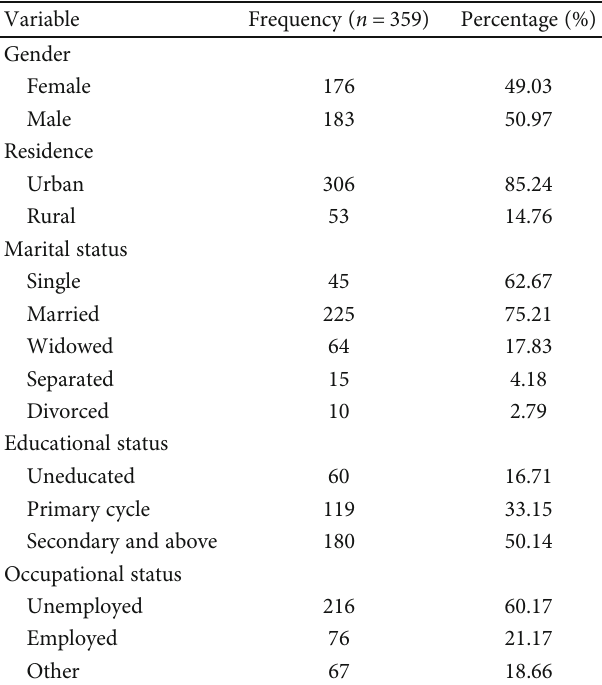
Table 2: Behavioral and clinical characteristics of diabetic patients at Adama hospital and medical college, Adama city, East Shewa, Ethiopia